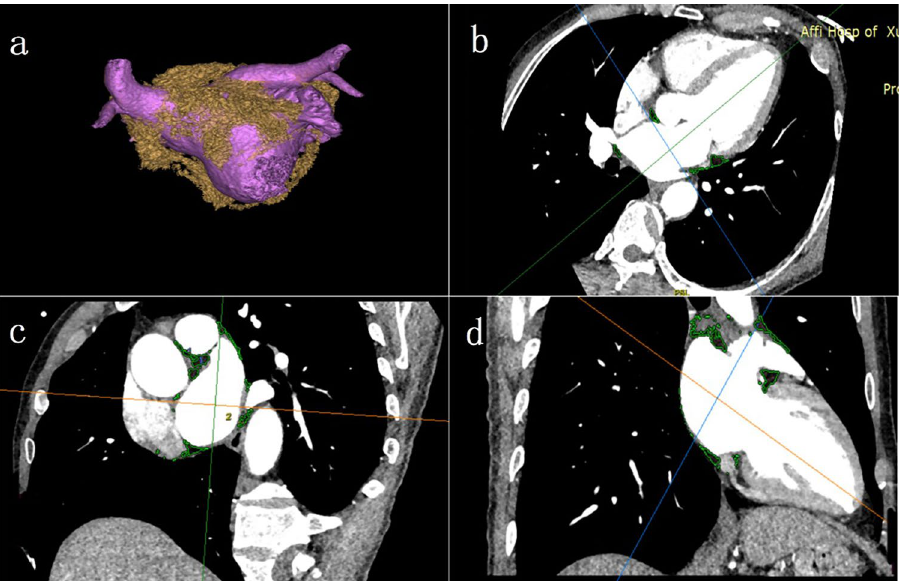
Figure 3. ( a ) The distribution of anterior and posterior left atrial epicardial adipose tissue (LA-EAT) around the left atrium, left atrial appendage and pulmonary veins (yellow represents fat); ( b–d ) the distribution of EAT under multi-planar reconstruction (green represents